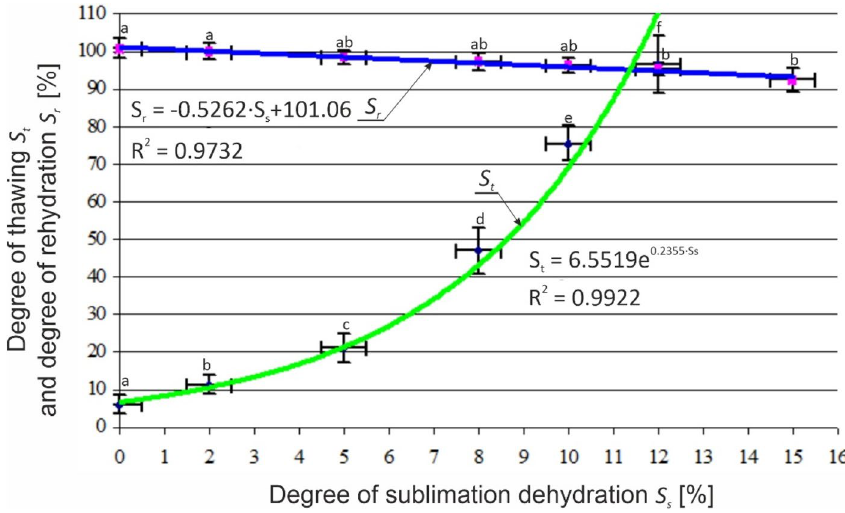
Figure 6. Dependence of the thawing degree S t and the rehydration degree S r for different degrees of sublimation dehydration S s